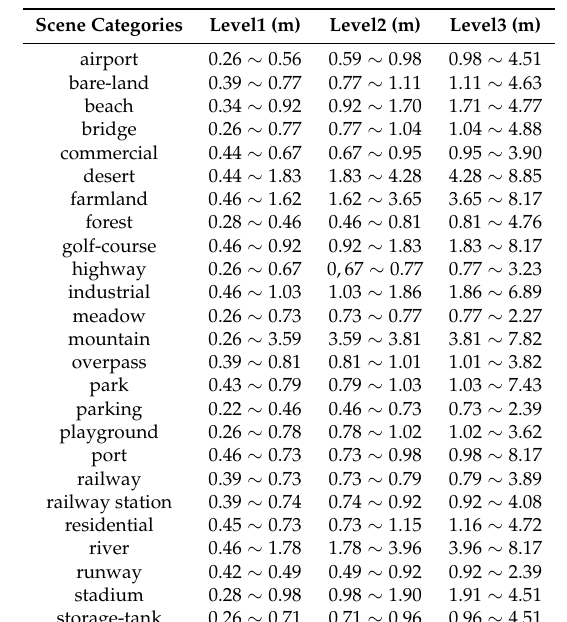
Table 2. Three levels of resolution range for each type of image of